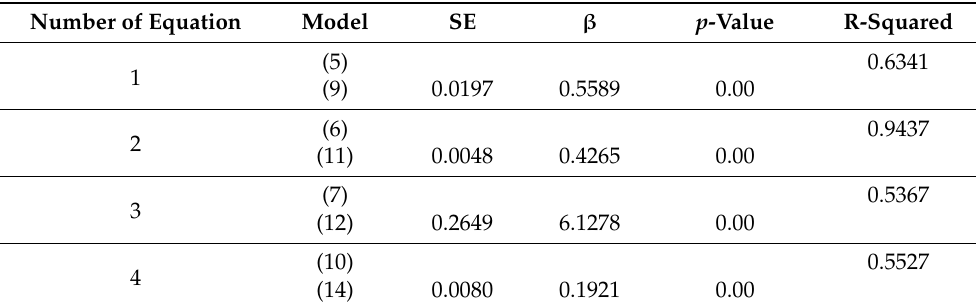
Table 2. Main indicators of regression